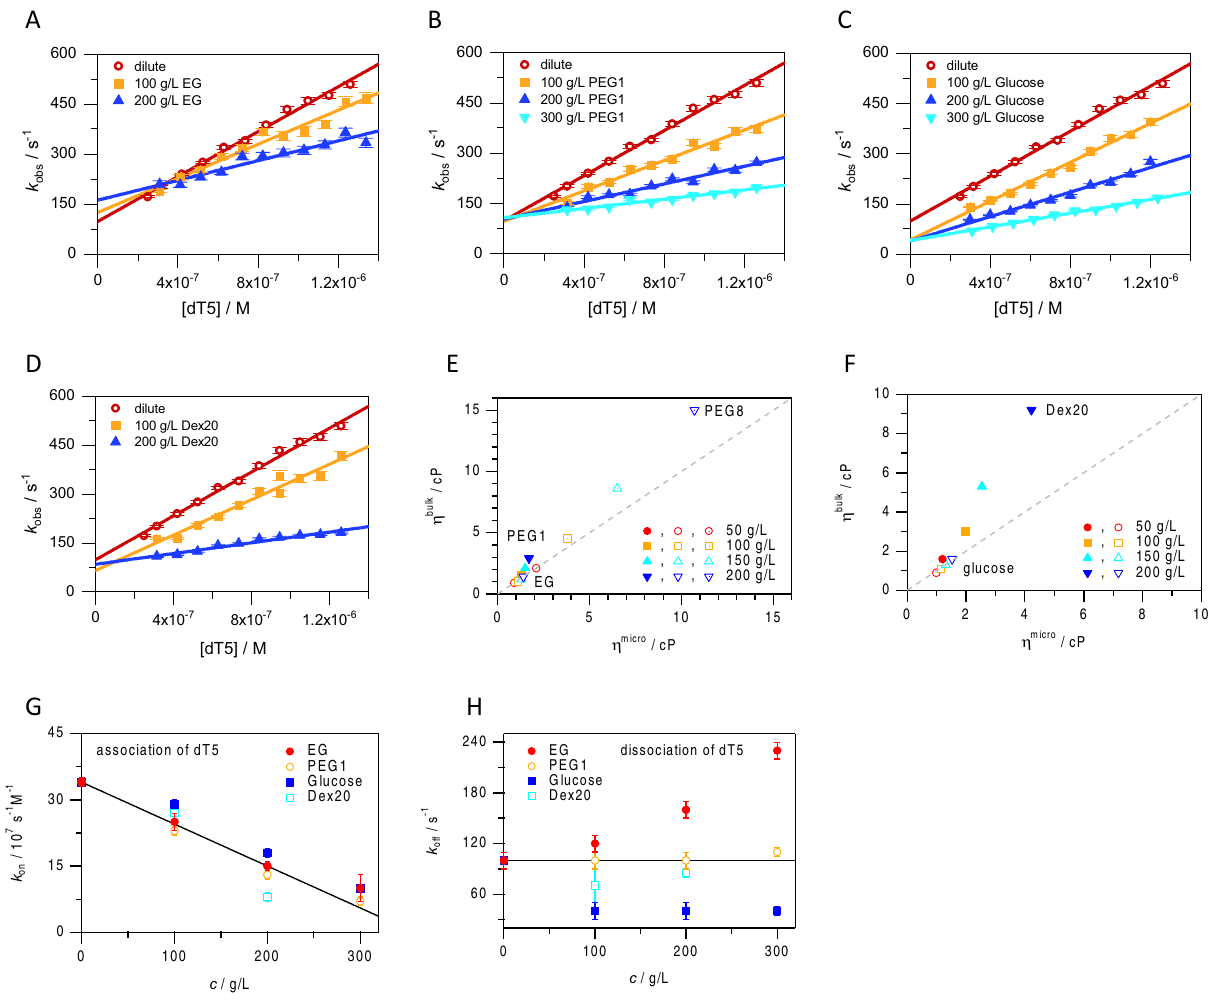
Figure 3. Probing the interaction between the oligothymidine dT5 and Bs CspB in absence and presence of a crowded environment by applying kinetic stopped-flow fluorescence spectroscopy considering viscosities of solvents. The apparent rate constant, k obs , has been obtained for different stoichiometric ratios between dT5 regarding Bs CspB under dilute (colored in red, circles) and different concentrations of EG ( A ), PEG1 ( B ), glucose ( C ), and Dex20 ( D ): 100 g/L (colored in orange, rectangles), 200 g/L (colored in blue, triangles with tip to top), and 300 g/L (colored in cyan, triangles with tip to bottom). All experiments have been performed at T = 288 K using c Bs CspB = 60 nM. A linear function has been used to perform regression analysis of experimental data regarding k obs (continuous line) to obtain rate constants of ligand association, k on , and dissociation, k off . Associated data are presented in Table 2 and Figs. S7A,B and S8A–C. ( E ) Dependence of macro- (η bulk ) and microviscosity (η micro ) on the concentration of PEG8 (symbols with central dot), PEG1 (closed symbols), and EG (open symbols). ( F ) Dependence of macro- and microviscosity on the concentration of Dex20 (closed symbols) and glucose (open symbols). The following concentrations of crowding agents have been used: 50 g/L (colored in red, circles), 100 g/L (colored in orange, rectangles), 150 g/L (colored in cyan, triangles with tip to top), and 200 g/L (colored in blue, triangles with tip to bottom). Diffusion coefficient, D , probed by NMR spectroscopy reports on the microviscosity of the sample. ( G , H ) Kinetic rate constants reporting on association and dissociation of dT5 to Bs CspB applying different crowded environments: EG (filled circles, colored in red), PEG1 (open circles, colored in orange), glucose (filled rectangles, colored in blue), Dex20 (open rectangles, colored in cyan). The continuous line represents a linear fit comprising all k on values independent of the crowding agent ( G ) as the k off value determined under dilute conditions ( H)